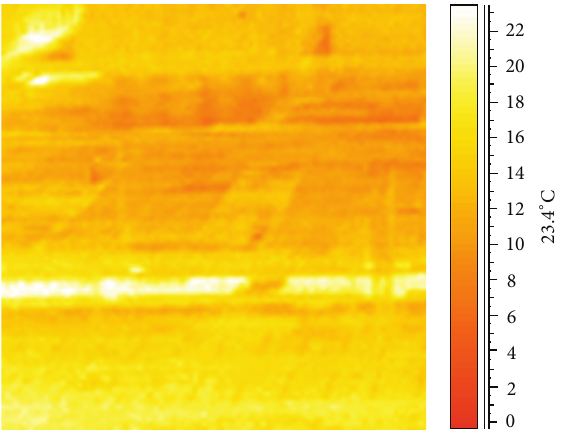
Figure 4: The TITI at 8 a.m. on May 20, 2008.